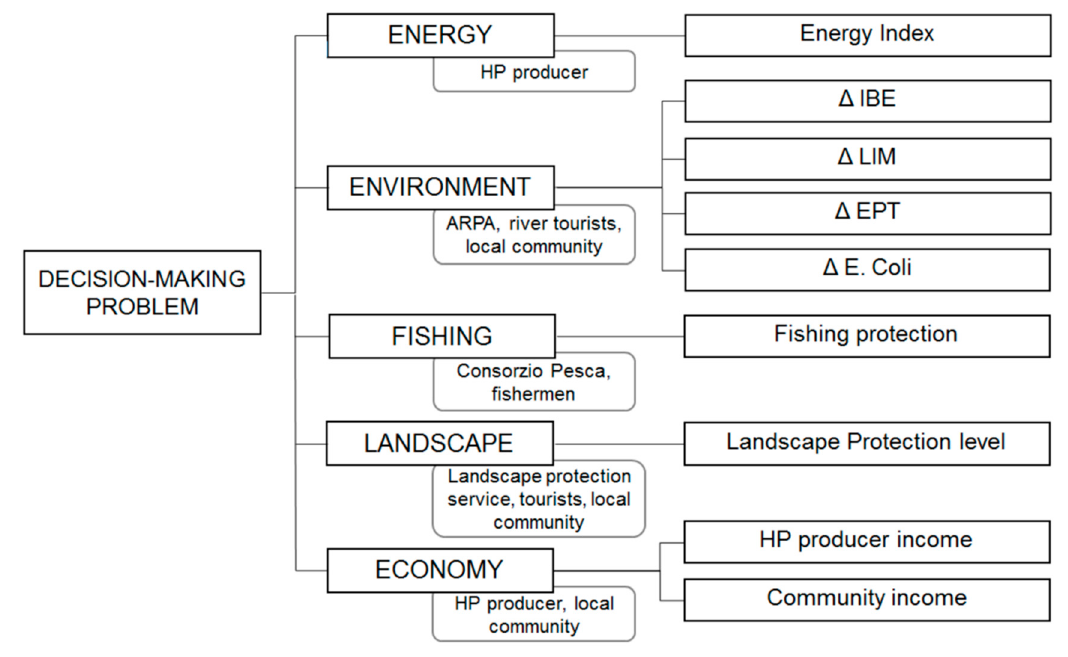
Figure 4. Initial decisional tree considered in Aosta Valley, representing the decision-making process that supports water withdrawal’s sustainability assessment. One or more indicators are associated to each of the five considered criteria, next to which the corresponding stakeholders are shown. The symbol, Δ , indicates the difference between the quality status upstream and downstream of the withdrawal point; the meaning of the environmental indexes is: IBE = Extended Biotic Index; LIM = Pollution Level of the Macro-descriptors; EPT = Ephemeroptera, Plecoptera, Tricoptera Richness Index; E. coli = Escherichia coli .